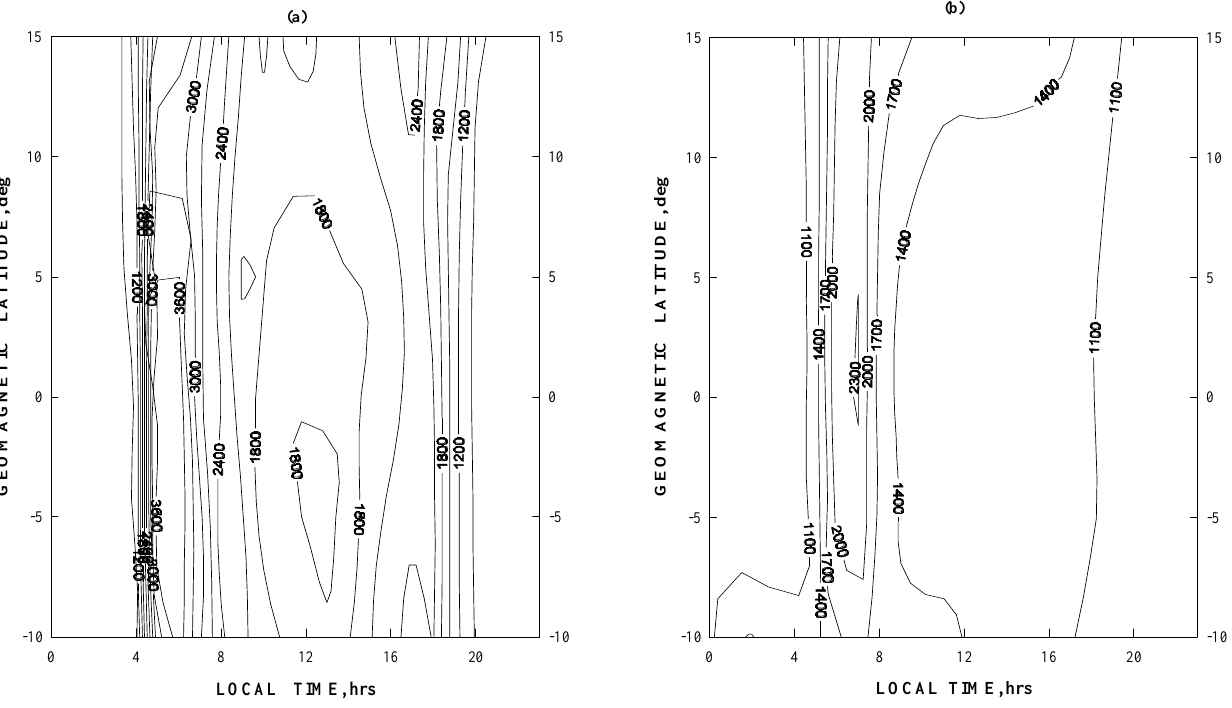
Fig. 2. Diurnal and latitudinal distribution of electron temperature at ∼ 500km for (a) observed (b) IRI in northern summer.